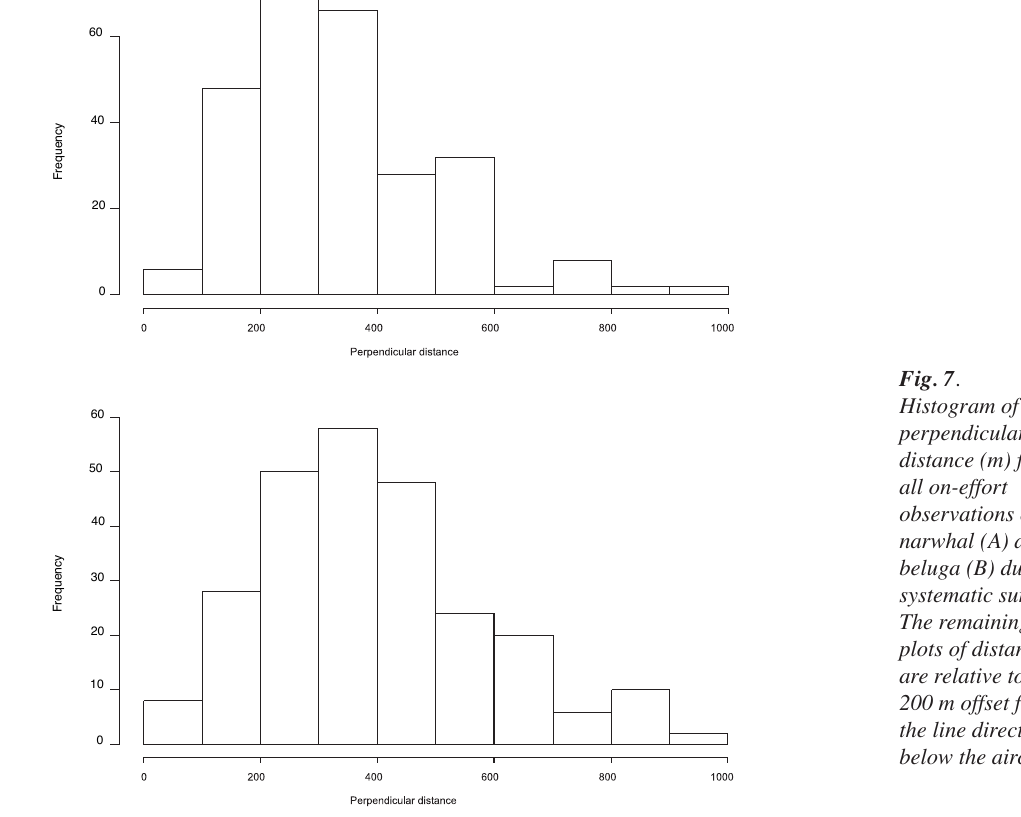
Fig. 7 . Histogram of perpendicular distance (m) for all on-effort observations of narwhal (A) and beluga (B) during systematic surveys. The remaining plots of distance are relative to the 200 m offset from the line directly below the